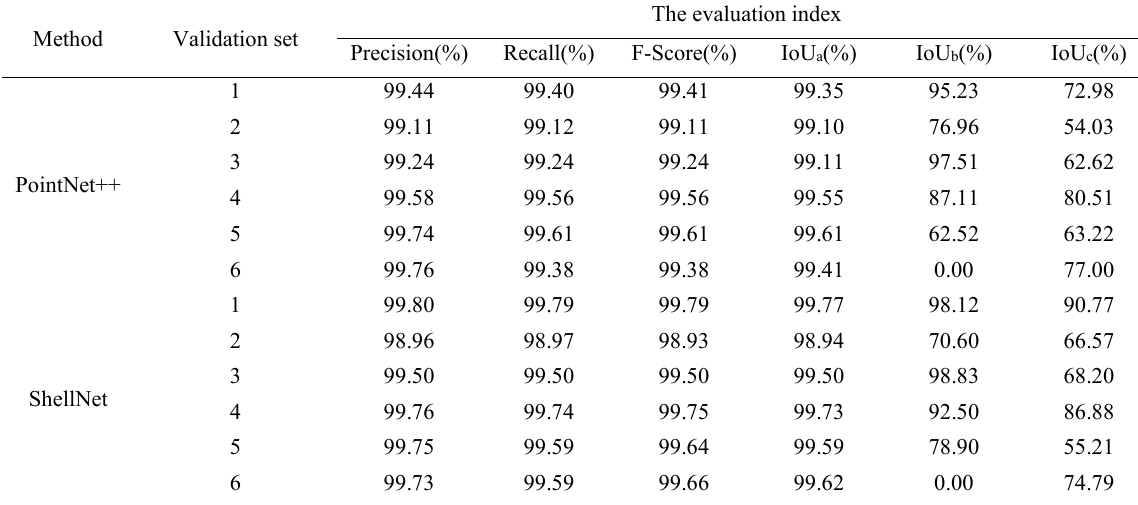
Table 1. In the six scenes divided into our data set, PointNet++ and ShellNet were used for segmentation experiments respectively, and the accuracy of their results was evaluated and compared with specific